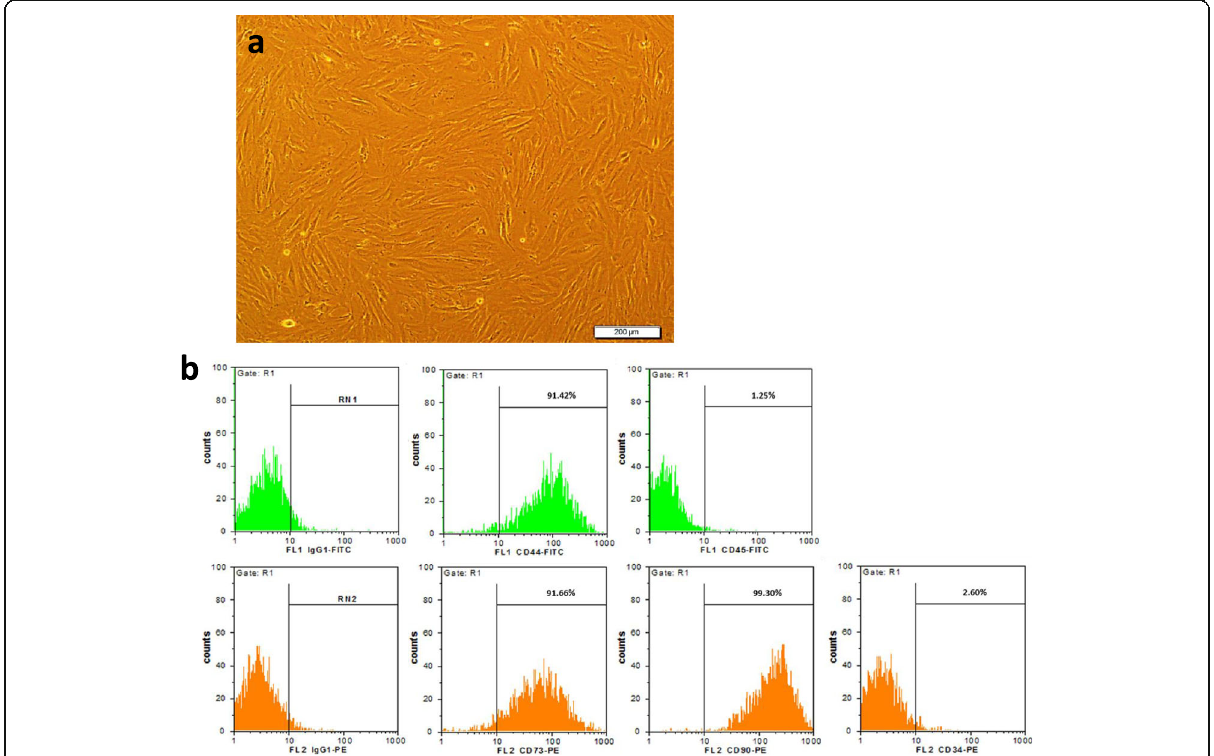
Fig. 1 Isolation and characterization of human bone marrow-derived mesenchymal stem cells. a BM-MSCs had fibroblast-like morphology after three passages (magnification ×4). b Cytofluorimetric analysis of the isolated cells at passage 3 revealed that they expressed CD44, CD73, and CD90 antigens, but they could not express hematopoietic and leukocyte markers, including CD34 and